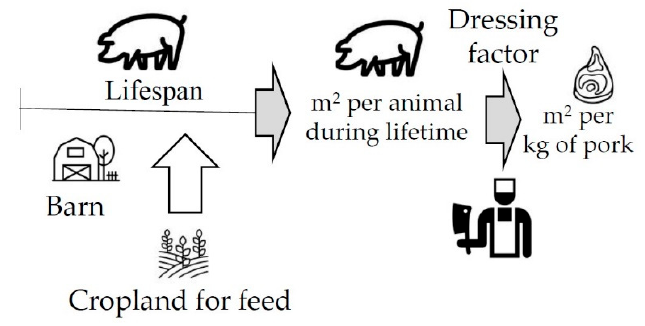
Figure 4. Pork production systems. Source of icons: the Noun Project [15].